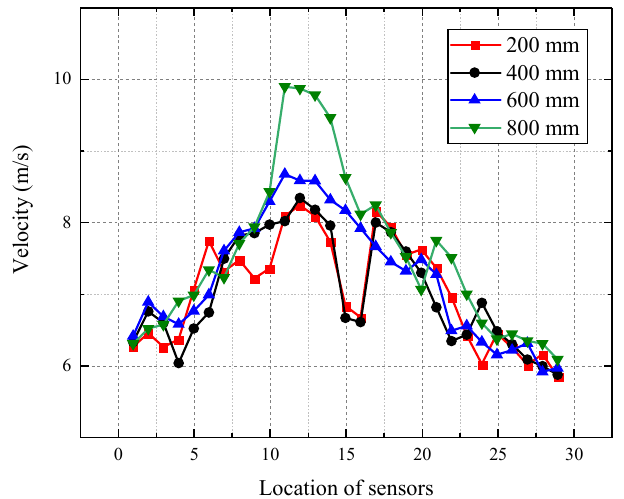
Figure 5. Distribution characteristics of wind speed at the entrance of the experimental section.